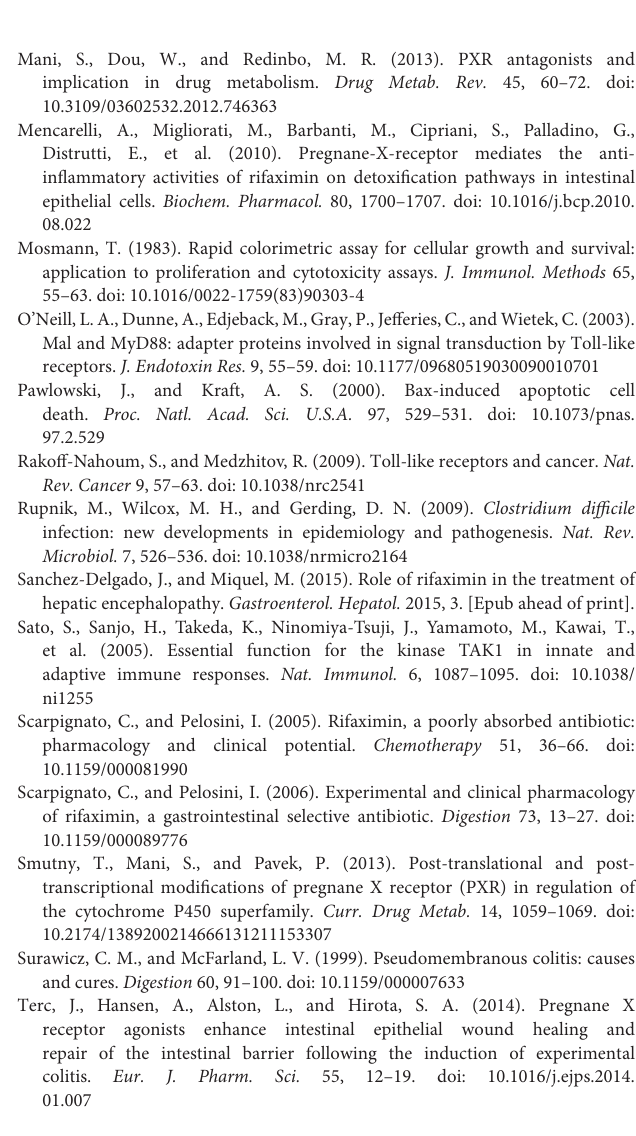
FIGURE S1 | (A) Agarose gel electrophoresis of cultured Caco-2 cell DNA in the presence of TcdA (30 ng/ml) alone or in the presence of increasing concentration of rifaximin (0.1–10 µ M) for 24 h. Rifaximin (10 µ M) was tested either alone, or in the presence of the PXR antagonist ketoconazole (10 µ M). Ketoconazole alone was unable to exert any significant effect on DNA damage. The results are representative of n = 3 independent experiments. (B) Western blot analysis showing immunoreactive bands referred to the pro-apoptotic active Caspase-3 protein. TcdA (30 ng/ml) induced a significant increase of Caspase-3 expression, that was significantly and concentration-dependently reduced by Rifaximin, whose effect was significantly inhibited by ketoconazole (10 µ M). Ketoconazole alone had no pro-apoptotic effect. (C) Relative quantification of immunoreactive bands of active caspase-3 protein (arbitrary units). Results are expressed as the mean ± SEM of n = 4 experiments performed in triplicate. ∗∗∗ P < 0.001 vs. vehicle group; ◦◦◦ P < 0.001, ◦◦ P < 0.01 vs. TcdA